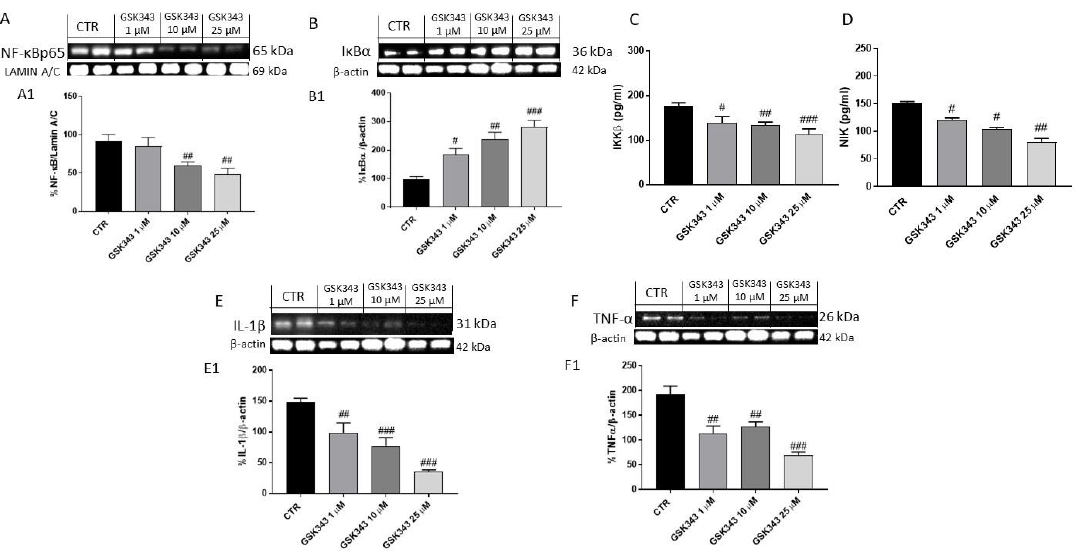
Figure 2. Effect of GSK343 treatment on NF- κ B/I κ B α pathway in U87 cell lysates. Our data demonstrated that the treatment with GSK343 at the concentrations of 1, 10 and 25 µ M significantly reduced NF- κ B ( A ), IKKβ expression ( C ) and res tored IκBα expression ( B ). Moreover, GSK343 treat- ment at the concentrations of 1, 10 and 25 μM significantly reduced NIK level ( D ), and pro-inflam- matory cytokines IL- 1β ( E ) and TNFα expression ( F ). Data are representative of at least three inde- pendent experiments. ( A ) ## p < 0.01 vs. Ctr; ( B ) # p < 0.05 vs. Ctr; ## p < 0.01 vs. U87 cells; ### p < 0.001 vs. Ctr; ( C ) # p < 0.05 vs. U87 cells; ## p < 0.01 vs. U87 cells; ### p < 0.001 vs. U87 cells; ( D ) # p < 0.05 vs. Ctr; ## p < 0.01 vs. Ctr; ( E ) ## p < 0.01 vs. Ctr; ### p < 0.001 vs. Ctr; ( F ) ## p < 0.01 vs. Ctr; ### p < 0.001 vs. Ctr.